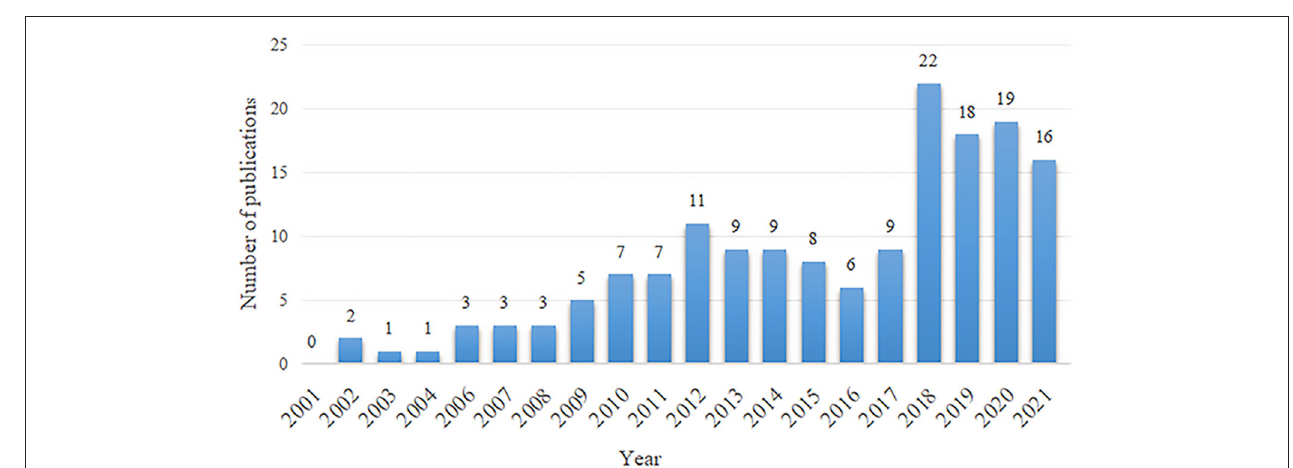
FIGURE 2 | The number of annual publications relating to research about the atrial fibrillation and depression from 2001 to